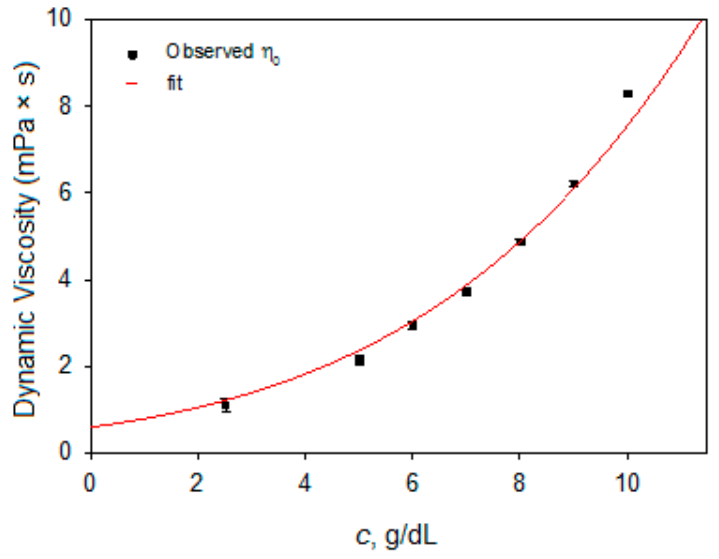
Figure 2. Dynamic viscosity as a function of spin-coating solution concentration. The fit line was determined by combining Equation (5) with Equation (7) (truncated at the third term) and solving for η 0 , with R 2 = 0.973 and standard error ± 0.34.